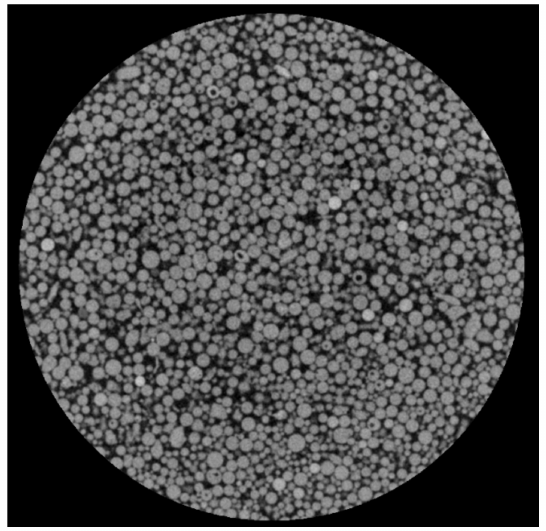
Figure 4. Slice image with micro-CT scanning showing indicating pores in black inside the grey particles for the spheroidise powder.